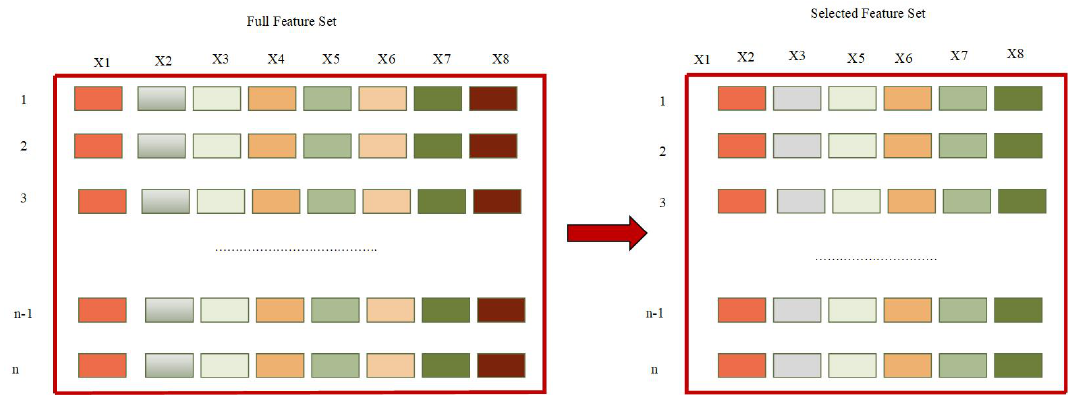
Figure 1. Feature selection